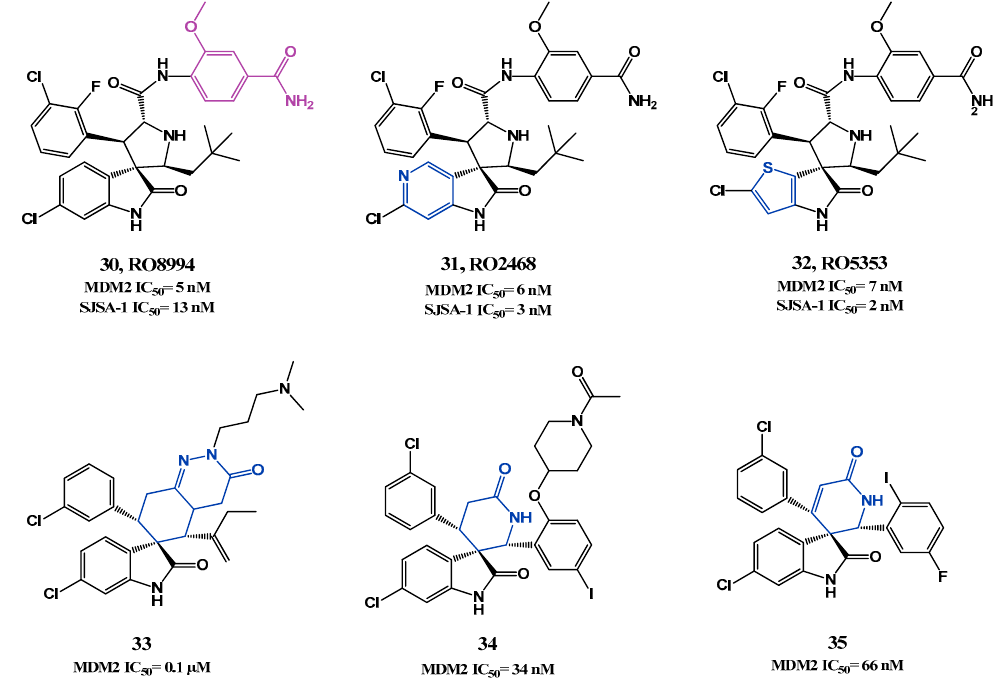
Figure 9. Spiropyrrolidines and others spiro-heterocyclic-oxindole derivatives.